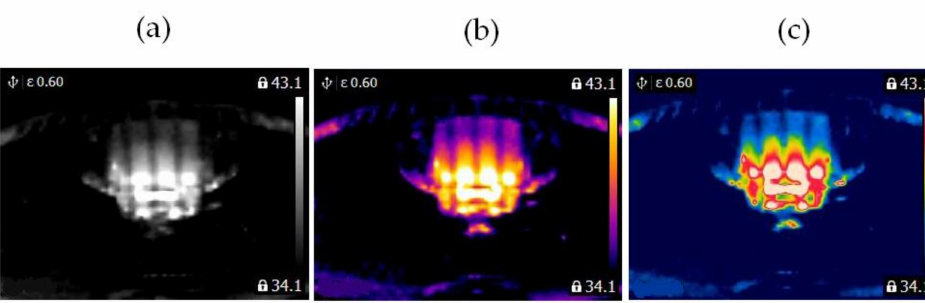
Figure 6. Healthy BLDC motor at 2100 rpm ( a ) gray-scale, ( b ) iron scale, ( c ) rainbow scale.